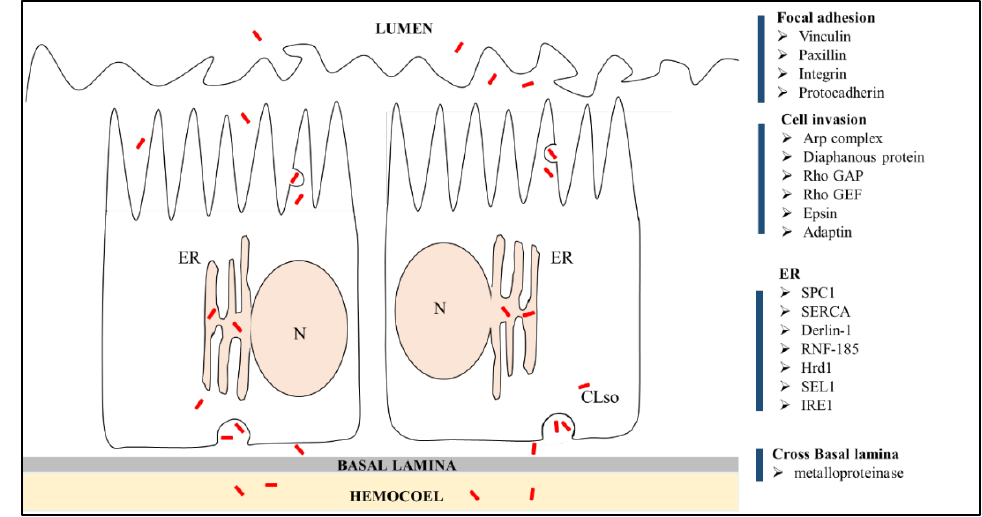
Figure 6. Illustration of putative candidate genes and their involvement in different stages of CLso (red particles) invasion in B. trigonica at the midgut/hemocoel interface. N: nucleus; ER: endoplasmic riticulum.